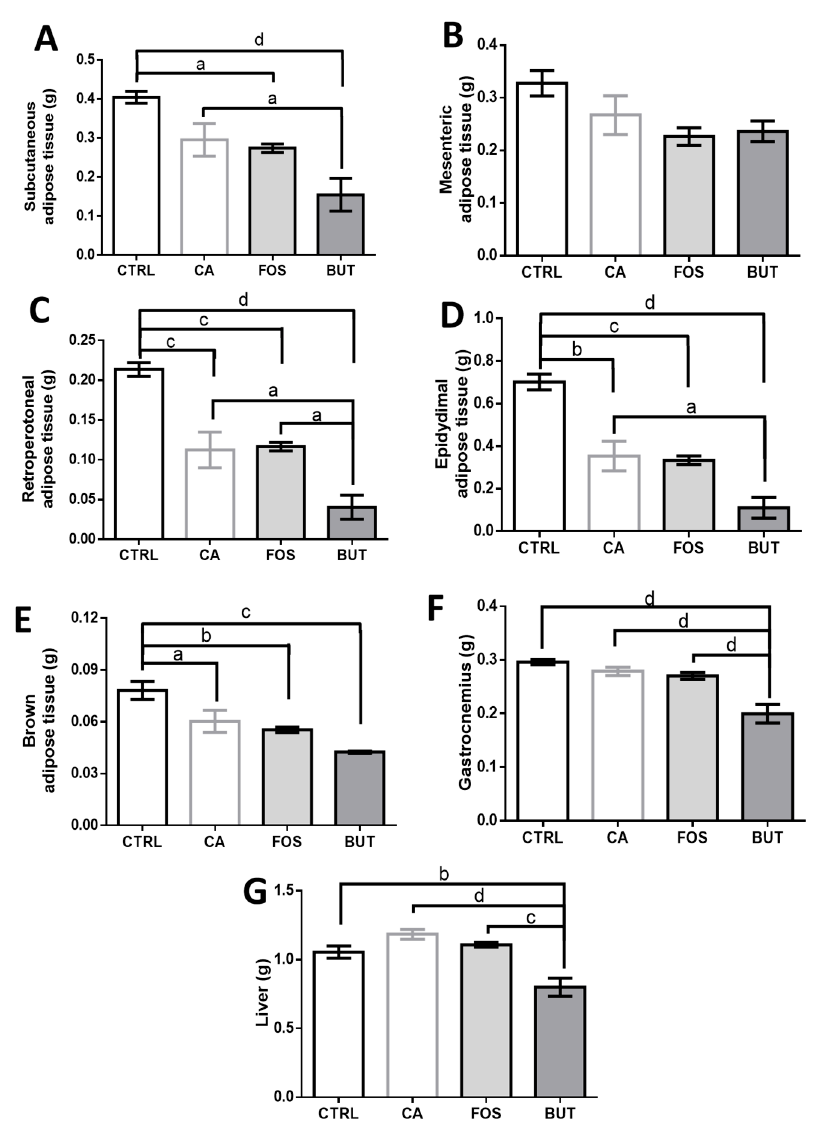
Figure 3. Butyrate reduces adipose tissue, gastrocnemius tissue mass, and liver weight: weights of subcutaneous ( A ), retroperitoneal ( B ), epididymal ( C ), mesenteric ( D ), brown ( E ), gastrocnemius skeletal muscle ( F ), and liver ( G ) tissue are presented below. Mice were divided into four groups: control group (CTRL— n = 9–10) fed with chow diet; and colon carcinogenesis-induced groups fed either with chow diet (CA— n = 9–10), tributyrin-supplemented diet (BUT— n = 5–6), or with FOS-supplemented diet (FOS— n = 9–10). Colon carcinogenesis was induced chemically by azoxymethane (AOM)/dextran sodium sulphate (DSS). Data are presented as means ± SEM. The groups were compared using one-way ANOVA followed by Bonferroni post hoc tests; for p < 0.05 (a), p < 0.01 (b), p < 0.001 (c), and p < 0.0001 (d).